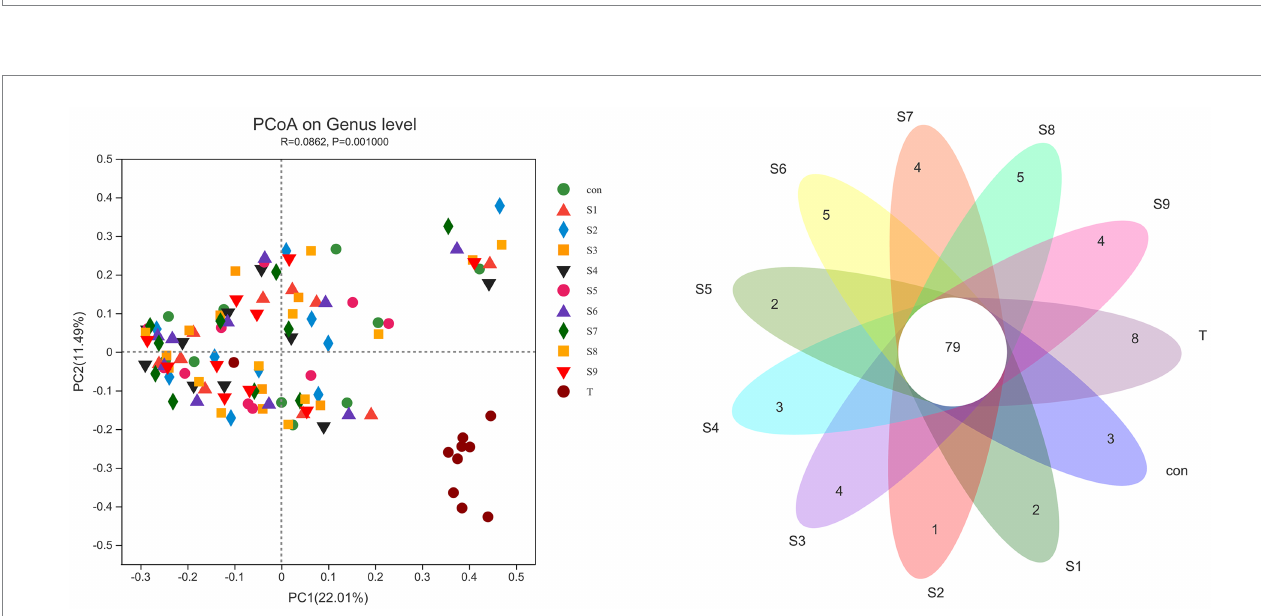
β -Diversity PCoA analysis and Venn diagram analysis of microbiota differences before and after fermentation. p < 0.05 indicates a significant difference between